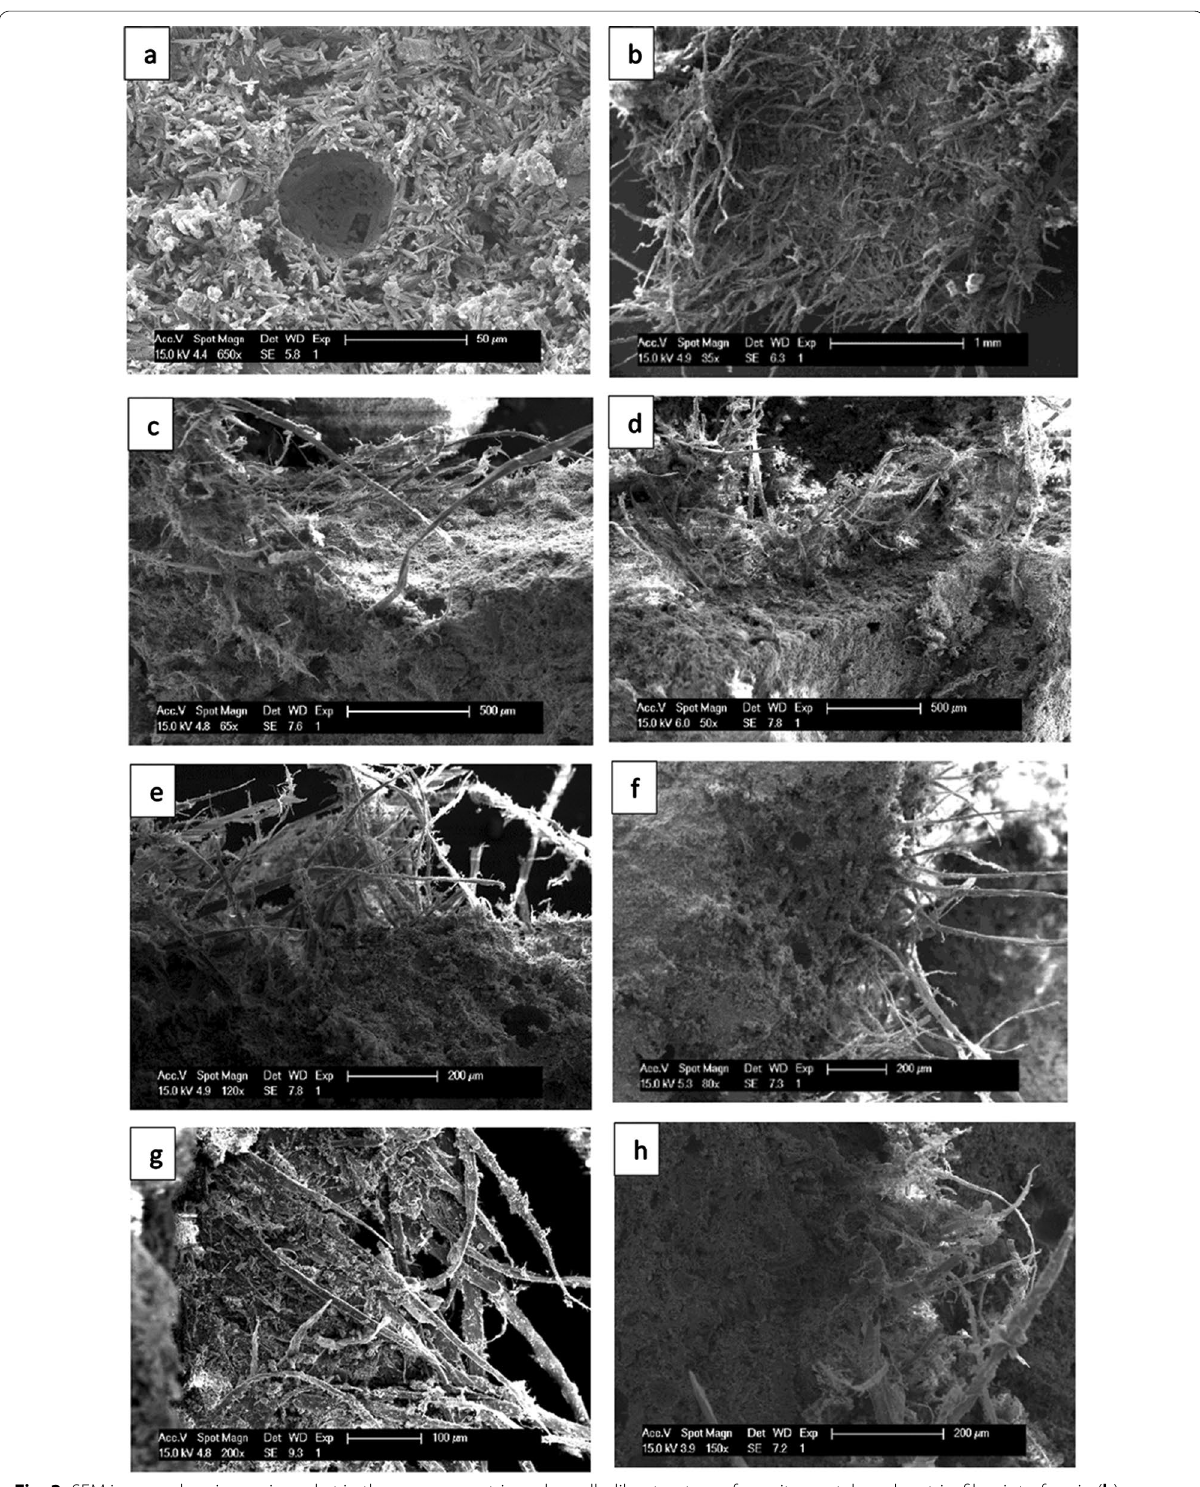
Fig. 3 SEM images showing a air pocket in the gypsum matrix and needle-like structure of gypsite crystals and matrix–fiber interface in ( b ) office paper–gypsum sample, c newspaper–gypsum sample, b magazine paper–gypsum sample, e corrugated board paper–gypsum sample, f corrugated paperboard–gypsum sample, g Tetra Pak I–gypsum sample, h Tetra Pak II–gypsum